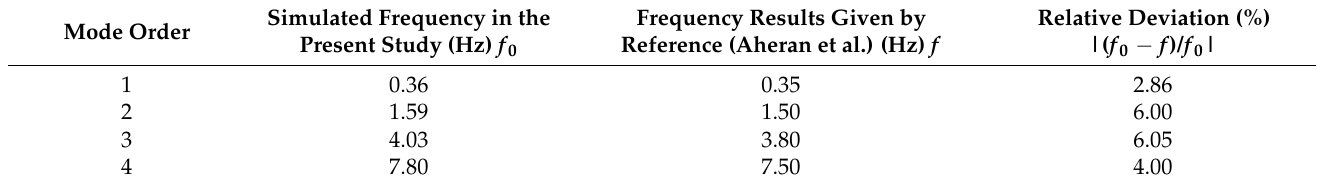
Table 1. Comparison of the simulated natural frequencies and the results given by reference